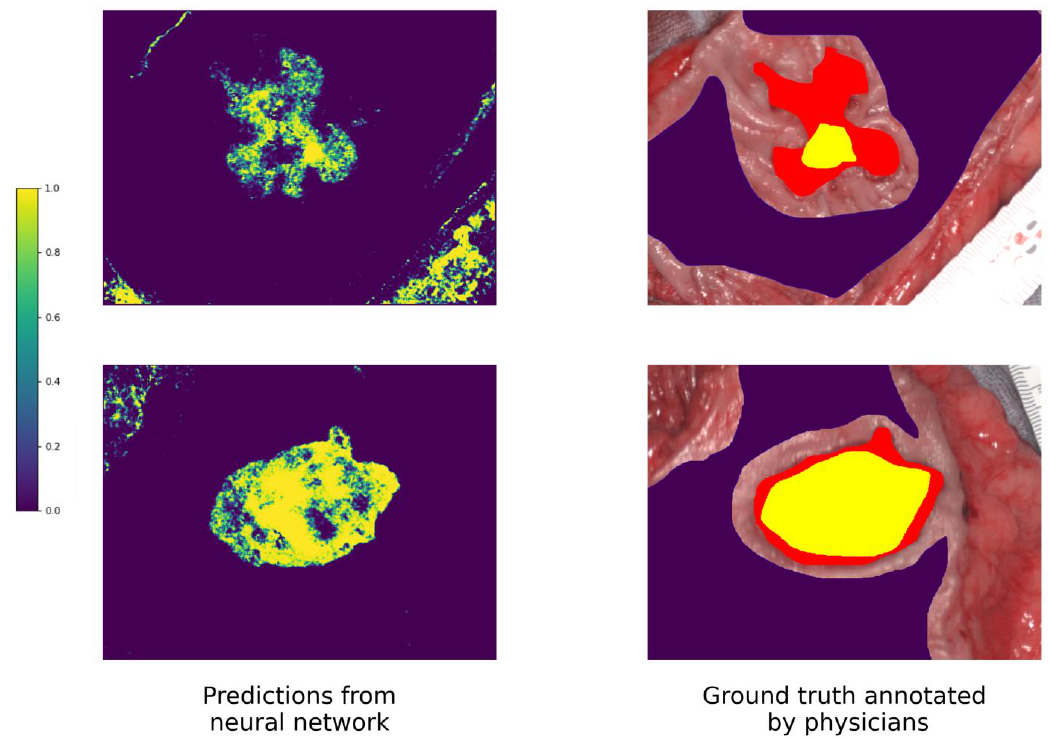
Figure 7. Prediction map examples in the left column and ground truth annotated by physicians on the right side, with the correspondence between colors and output probabilities shown on the color bar. Yellow represents cancerous tissue, purple non-malignant tissue, and red the margin of the cancer.